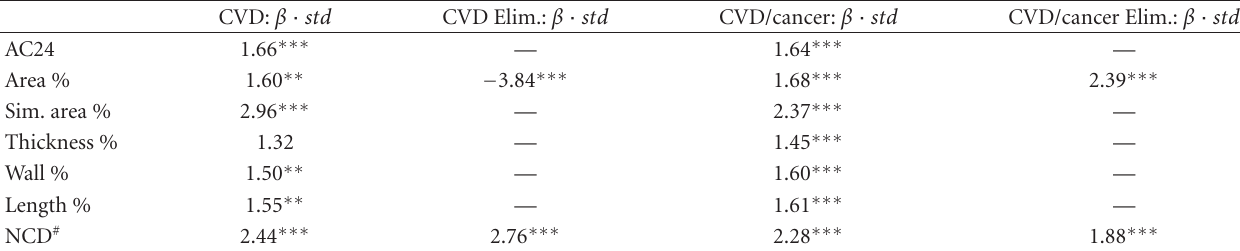
Table 5: The individual hazard ratios for the markers in the CVD and the CVD/cancer group as well as two Cox regression elimination models. First the nonadjusted hazard ratios from Table 2 are stated again, and then two elimination models are shown. The symbols ∗ , ∗∗ , and ∗∗∗ denote the significance corresponding to P < 0 . 05, P < 0 . 01, and P < 0 . 001, respectively. # NCD stands for number of